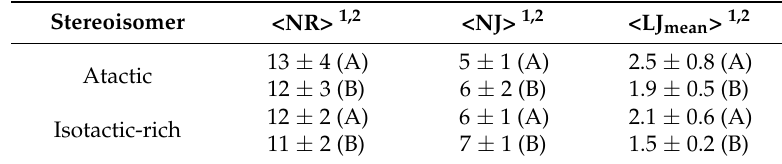
Table 2. Features of the interchain junctions at 323 K.